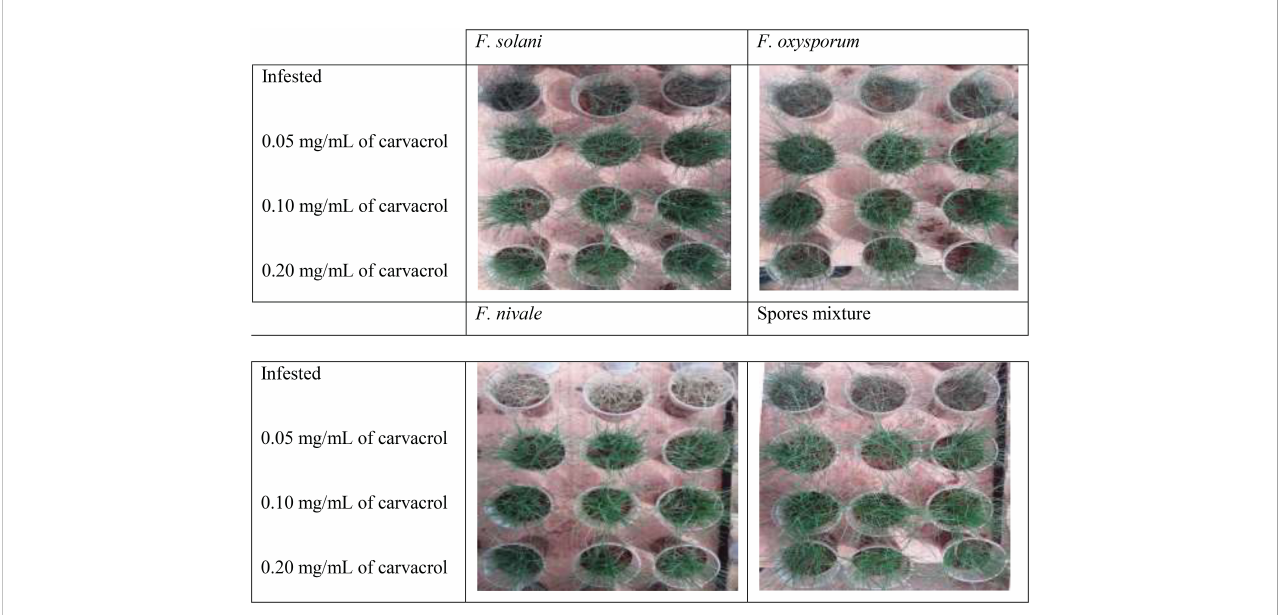
FIGURE 6 The visual appearance of the health status of ryegrass in disinfected soil after 4 weeks of preventive treatment with carvacrol under greenhouse conditions.